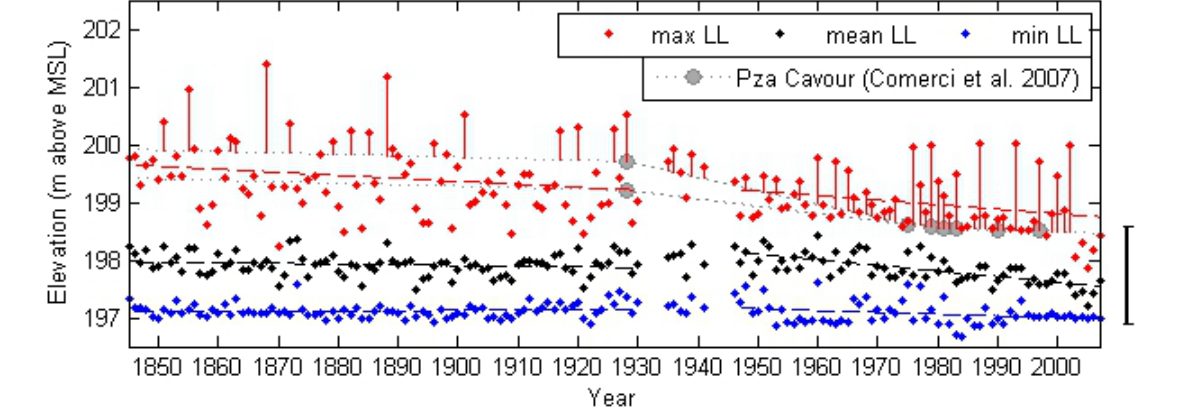
Fig. 2 . Maximum (red dots), mean (black dots), and minimum (blue dots) annual lake levels since 1845 (original data: Consorzio dell’Adda); and elevation of Piazza Cavour (gray dots, Comerci et al. 2007). Vertical red lines indicate the positive difference between maximum lake level and elevation of Piazza Cavour (e.g., flooding). The black line on the right represents the regulation